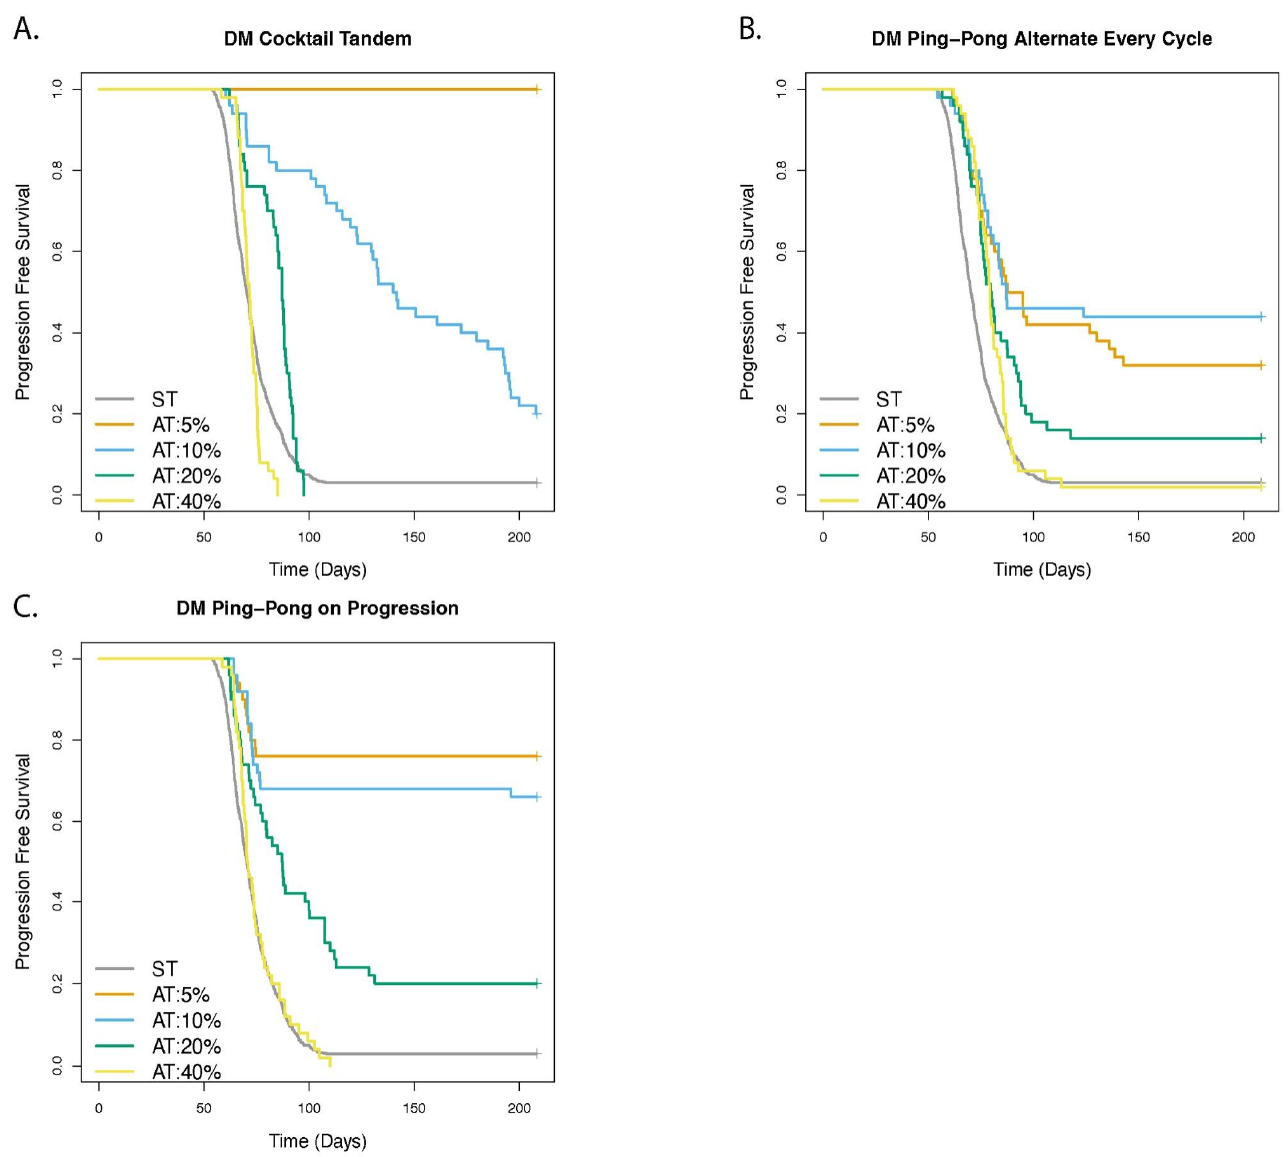
Figure 8. Delta Tumor is an important parameter determining outcome of dose modulation (DM) adaptive therapy. The panels show the comparison of adaptive therapy (AT) versus standard treatment (ST) as the Delta Tumor parameter is varied for A. DM Cocktail Tandem, B. DM Ping-Pong Alternate Every Cycle, C. DM Ping-Pong on Progression. For the dose modulation (DM) protocols, Delta Tumor is the tumor measurement parameter specifying a relative value by which the tumor burden must change, compared with the last time it was measured, in order to trigger a change in drug dosage.